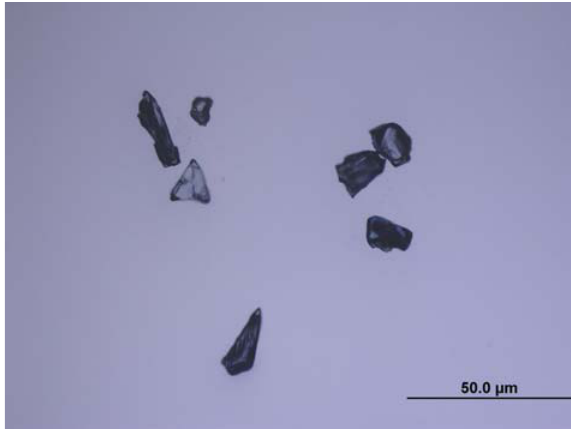
Figure 4- Whiteness RM - irregular silicone carbide particles